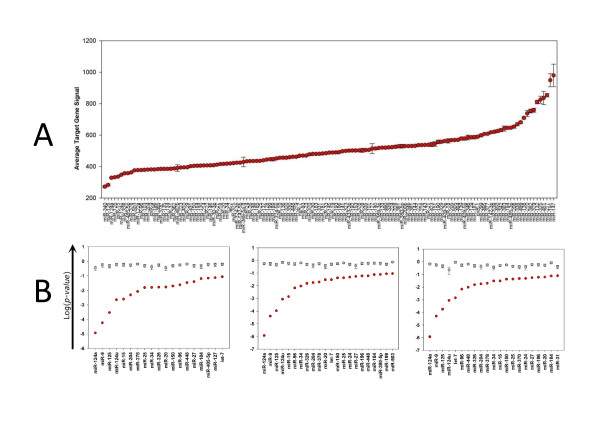
miRNA target gene expression. (A) miRNAs ranked by target gene expression levels (Average Target Gene Signal) in P4 retina. (B) Probabilities of each miRNA having a significant effect (p < 0.1) upon target gene expression according to Wilcoxon ranked sum test. The log10(p-value) for each miRNA (x-axis) is plotted as a red circle and the mean probability (± standard error) derived from five random sets of predicted target genes is plotted in grey.